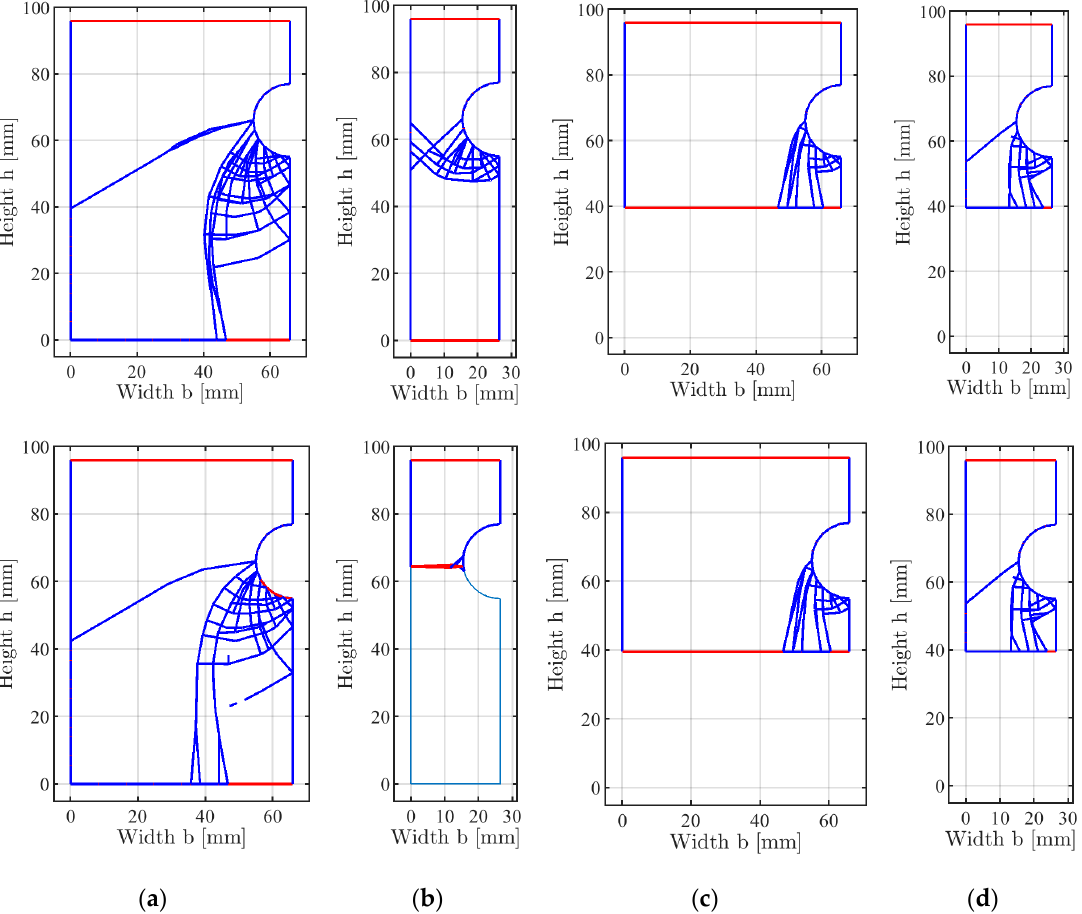
Figure 18. Failure mechanisms (blue: Slip displacements, red: Normal displacements) from DLO with k fy = 2.50 (top row: T resca ; bottom row: M ises ): ( a ) Case 1; ( b ) Case 2; ( c ) Case 3; ( d ) Case 4.